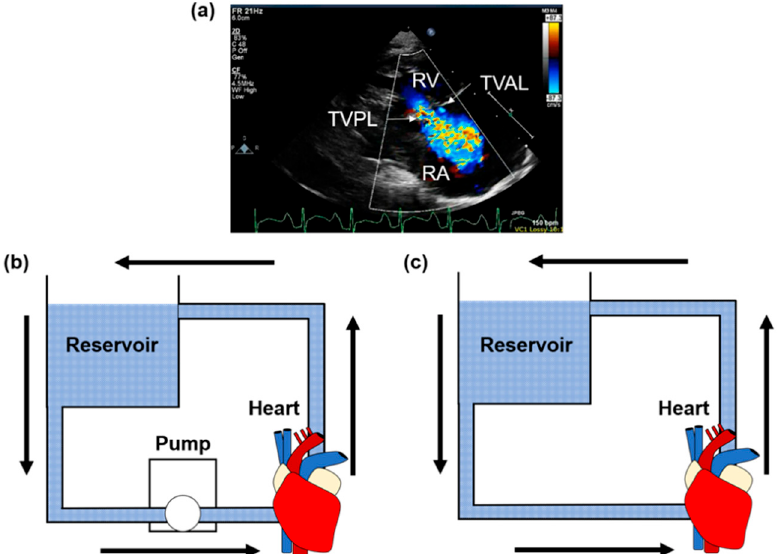
Figure 7. Example methodologies for investigating TV annulus dynamics: ( a ) clinical 3DE in-vivo imaging (image courtesy of Dr. Mir and Dr. Burkhart from the Children’s Heart Center at the University of Oklahoma Health Sciences Center), ( b ) an in-vitro pump-driven fluid flow loop paired with sonomicrometry, or ( c ) a Langendorff model (or a working heart model) paired with sonomicrometry.